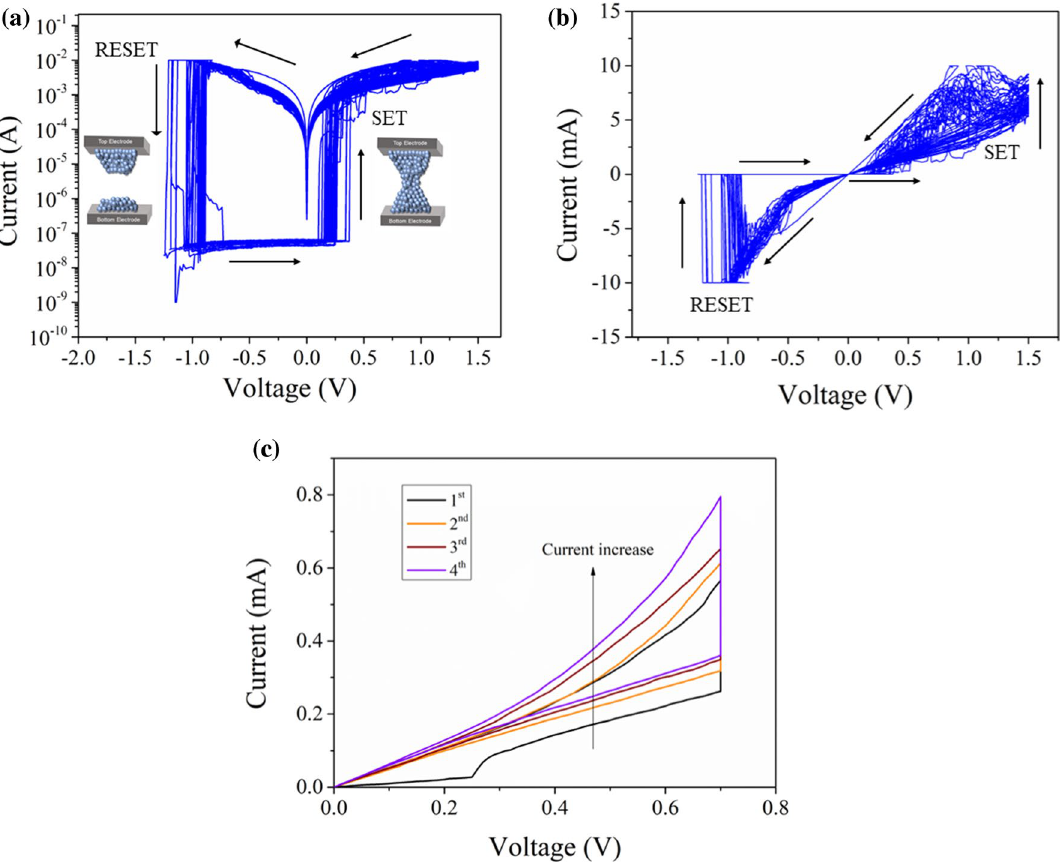
Fig. 2 30 I-V Resistive switching loops of the RbCsFAMA synaptic Device in ( a ) Logarithmic and ( b ) Linear Scale, ( c ) Four Consecutive I-V sweeps from 0 V to 700 mV to 0